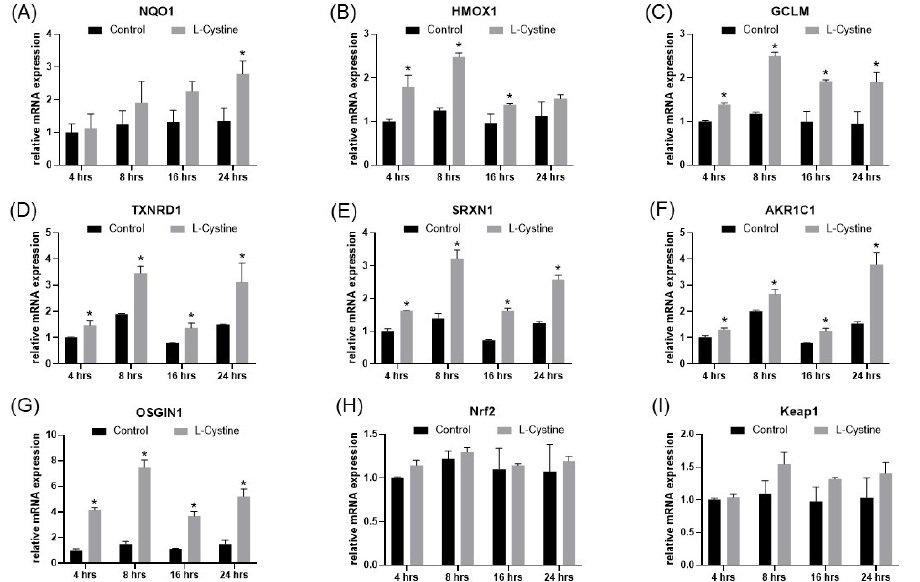
Figure 6. RT-PCR Measurements of Nrf2 Downstream Genes by L-Cystine Treatment. HeLa cells without or with 0.8 mM L-Cystine treatment were harvested at the indicated time for extraction of total RNA. The RNA (1 μ g) was reversely transcribed into cDNA for qPCR to measure the levels of genes. The data represent means ± SD from triplicates for the abundance of the gene transcript over that of 18S rRNA ( A – I ). * indicates statistically significant compared to the control at the same time point as the adjusted p value < 0.05 by two-way ANOVA, corrected by Turkey’s multiple comparisons test ( A – I ).